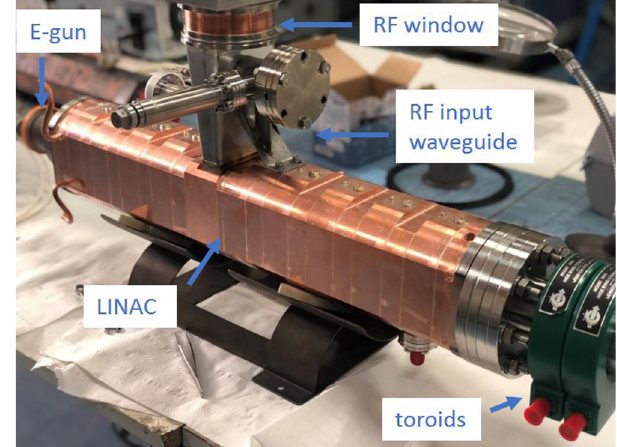
FIG. 14. Linac after brazing. The electron gun and the rf window are welded onto the structure. Two magnetic toroids (in green) for beam current monitoring are located on the output beampipe.